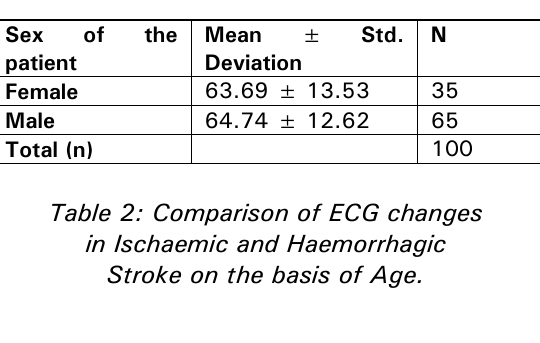
Table 1: Mean age and standard deviation of male and female patients.